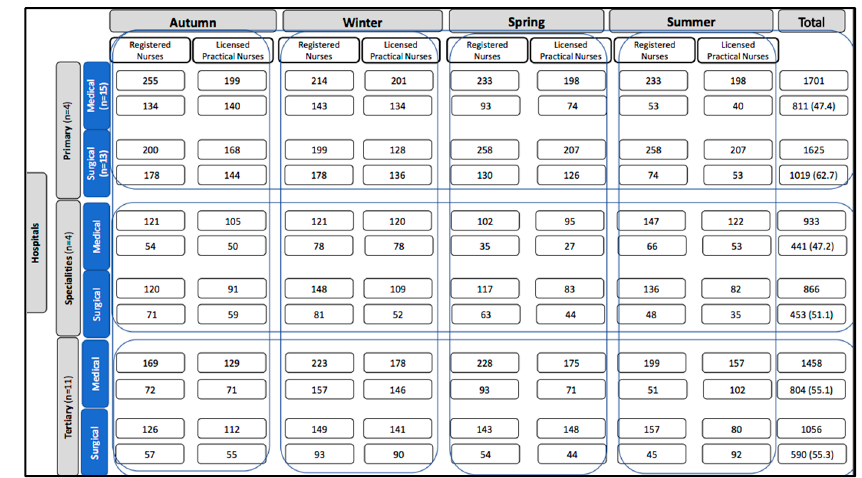
Figure 1. Sampling and recruitment flow chart.